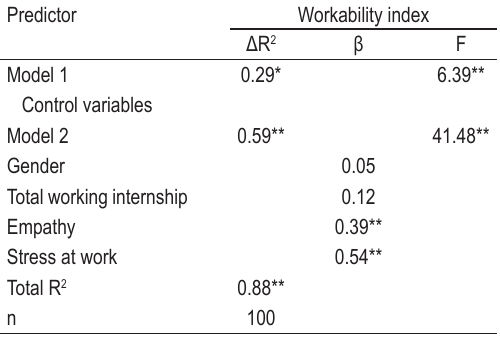
TABLE 4. Hierarchical multiple regression analysis of workability predict based on empathy and the perception of stress at work